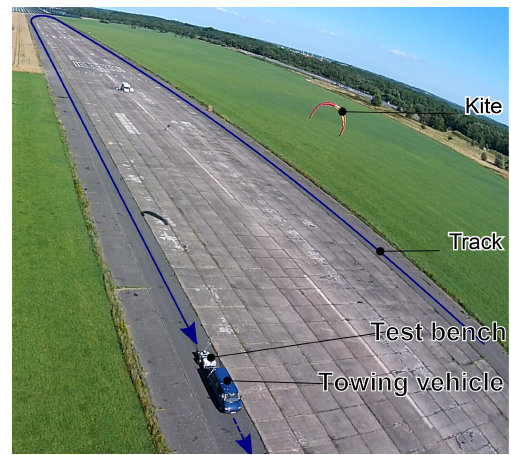
Figure 12. Dynamic test